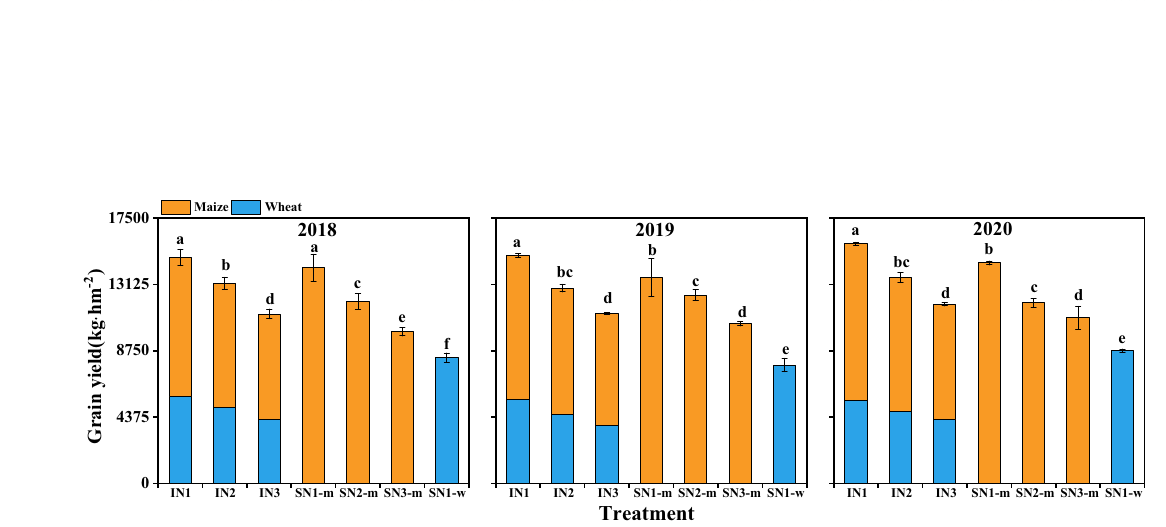
Table 2. Dry matter translocation and contribution rate to grain yield of leaf, stem, and husk in maize of intercropping and sole cropping systems under different N management. Means with the same lowercase letters in the same column are significantly different at P ≤ 0.05. a Intercrop and sole crop means the intercropped maize and sole maize. b For intercropping, N 1 , N 2 , and N 3 represent N-fertilizer applied at 51, 72, and 93 kg N ha −1 as first top-dressing plus 63, 42, and 21 kg N ha −1 at third top-dressing, respectively. For sole cropping, N 1 , N 2 and N 3 represent N-fertilizer applied at 36, 72, and 108 kg N ha −1 as first top-dressing plus 108, 72, and 36 kg N ha −1 at third top-dressing, respectively. c DTA is transportation amount of dry matter in vegetative organ (kg); DTR is transfer rate of dry matter in vegetative organ (%); GCR is contribution rate of vegetative organs to grain (%).